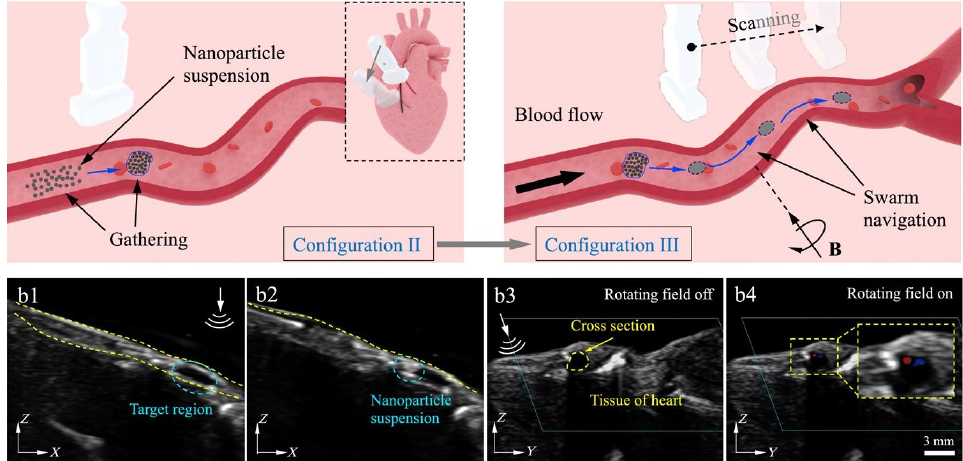
Figure 9. Magnetic microswarm tracked by US imaging. Reproduced with permission from ref [84]; published by AAAS,